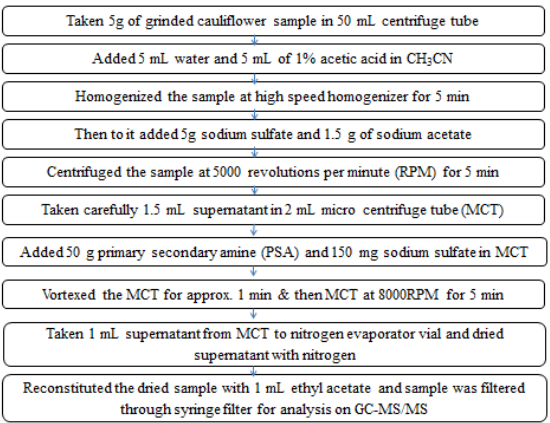
Figure 2. Extraction and clean up procedure of pesticides from cauliflower [13]